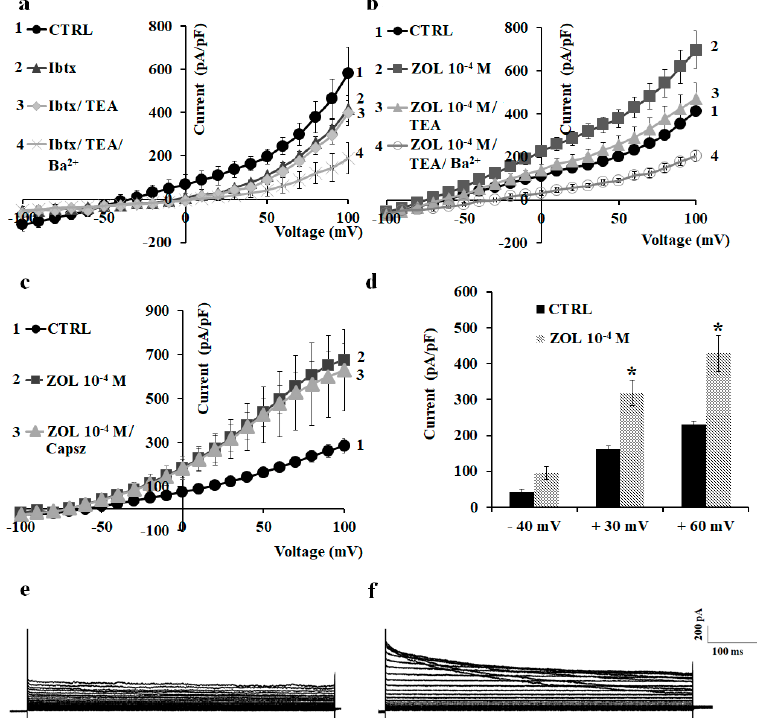
Figure 4. Characterization of the inwardly and outwardly macroscopic K + currents recorded in RAW264.7 preosteoclast-like cells using a whole-cell configuration. Currents were recorded under physiological K + ion concentration in the bath and pipette, and were obtained in response to voltage pulses from − 100 to +100 mV in 10 mV steps, starting from HP = − 60 mV (Vm). Cells of about the same size were selected for patch clamp experiments. Each point represented the mean ± SEM ( N patches = 5–8). ( a ) Current–voltage relationships in response to the application of Ibtx (4 × 10 − 7 M); Ibtx and TEA (5 × 10 − 3 M); and Ibtx, TEA, and Ba 2+ (5 × 10 − 3 M). ( b ) Macroscopic currents induced by zoledronic acid (ZOL) (10 − 4 M) in RAW264.7 inhibited by TEA (5 × 10 − 3 M). ( c ) Current response to capsazepine (Capsz) (10 − 6 M). This compound failed to reduce ZOL-evoked current. ( d ) Change of current amplitudes at − 40, + 30, and + 60 mV (Vm) after ZOL application (10 − 4 M) on RAW264.7 cells. * Data significantly different with respect to the controls ( p < 0.05; Student t -test). ( e ) Sample traces of control (CTRL) current and ( f ) ZOL (10 − 4 M)-evoked instantaneous current.